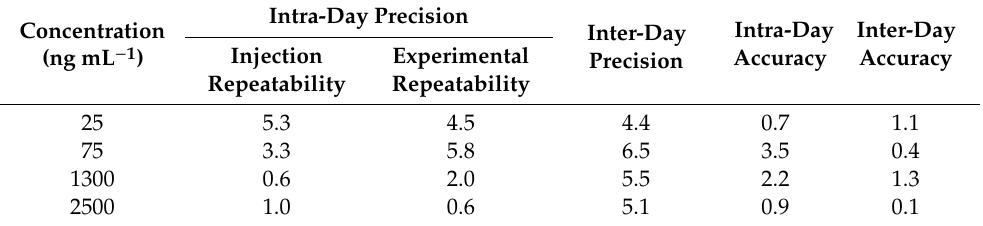
Table 1. Intra-day and inter-day precision and accuracy of β -ODAP. Results are expressed as %.